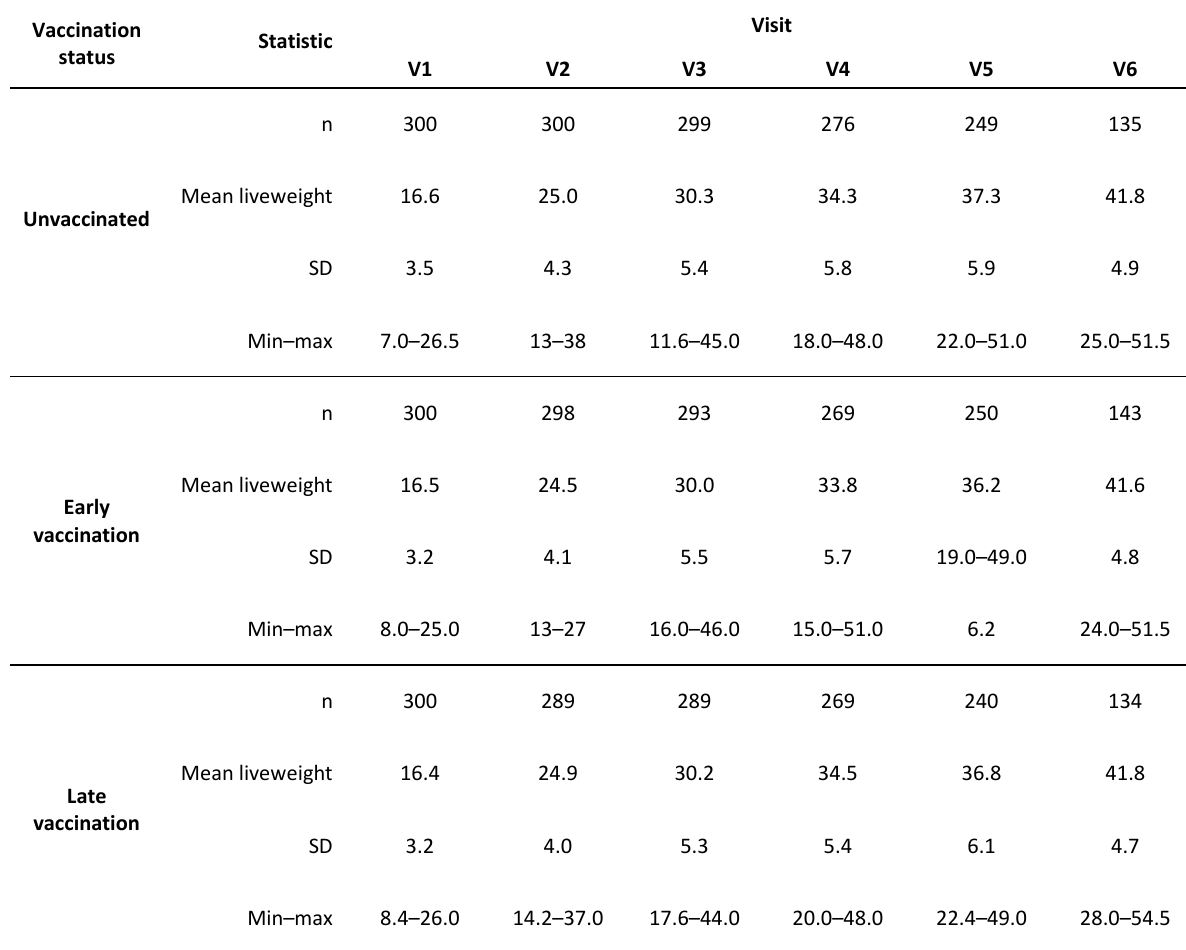
Table 5 Mean, standard deviation (SD) and range (min–max) in liveweight (kg) of unvaccinated, early and late vaccinated trial lambs at each of the six visits (V1 to V6) on six sheep